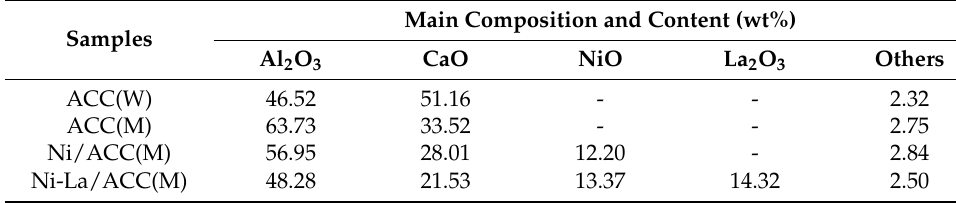
Table 1. XRF analysis of supports and catalysts.